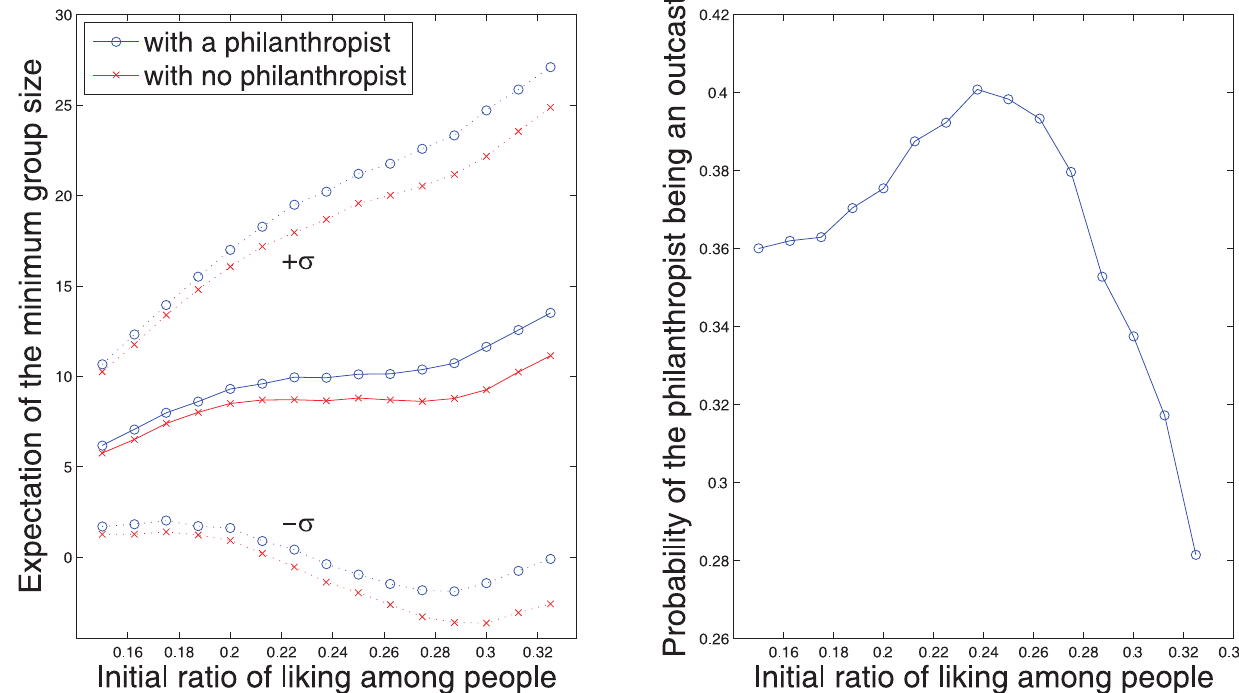
Figure 5. Influence of an philanthropist on the group formation. Except the philanthropist ( a =0), other people maintain a =1. The group configuration at t =40 is used in the graphs. The results are based on 10,000 realization of the Monte Carlo simulation.